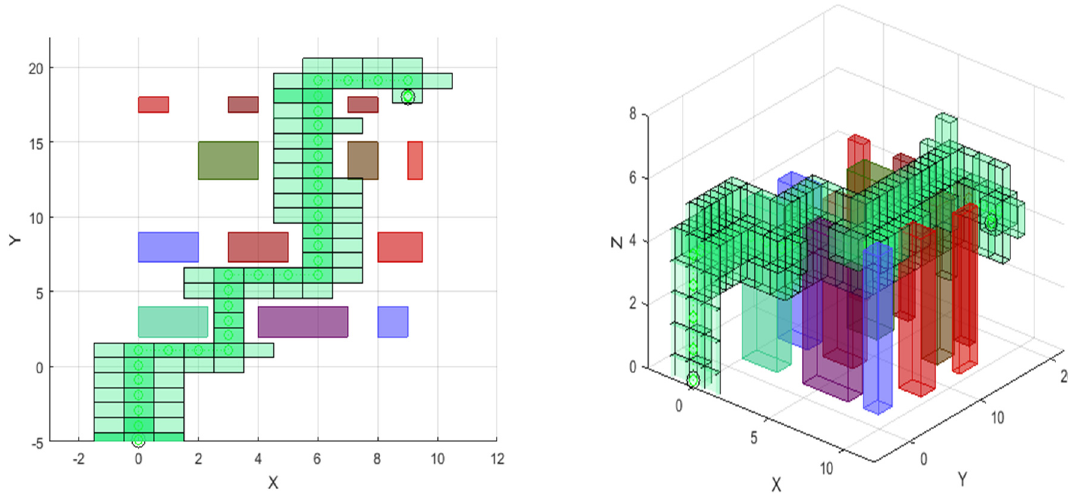
Figure 7. Path generated by conventional A* algorithm between start and goal points (2D and 3D